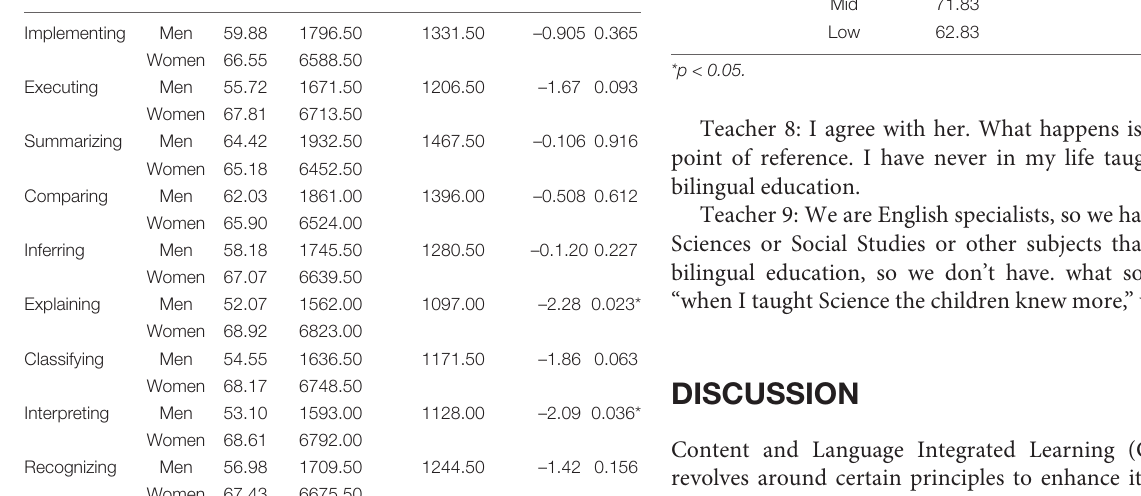
Sum of Mann-Whitney U Z p. rank ranks